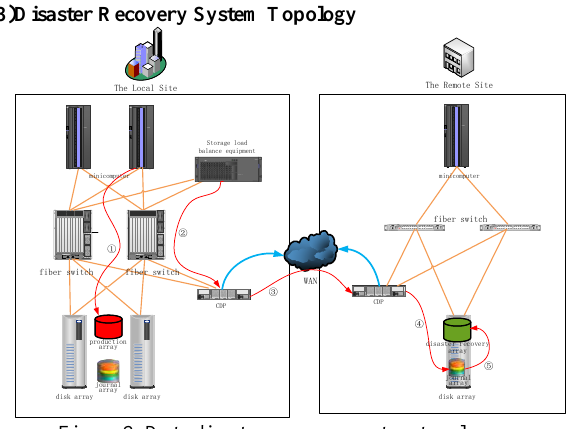
Figure 2. Data disaster recovery system